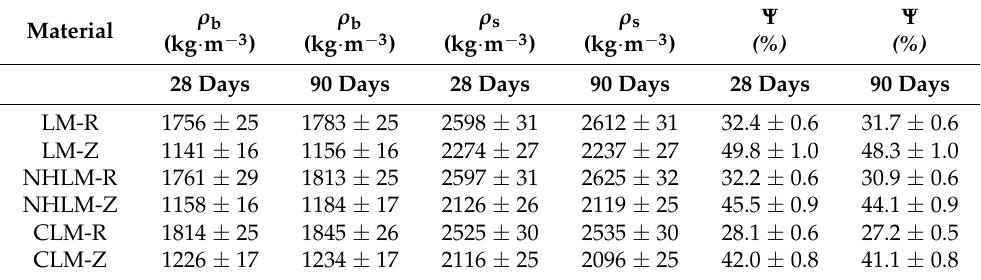
Table 4. The macrostructural properties of the hardened